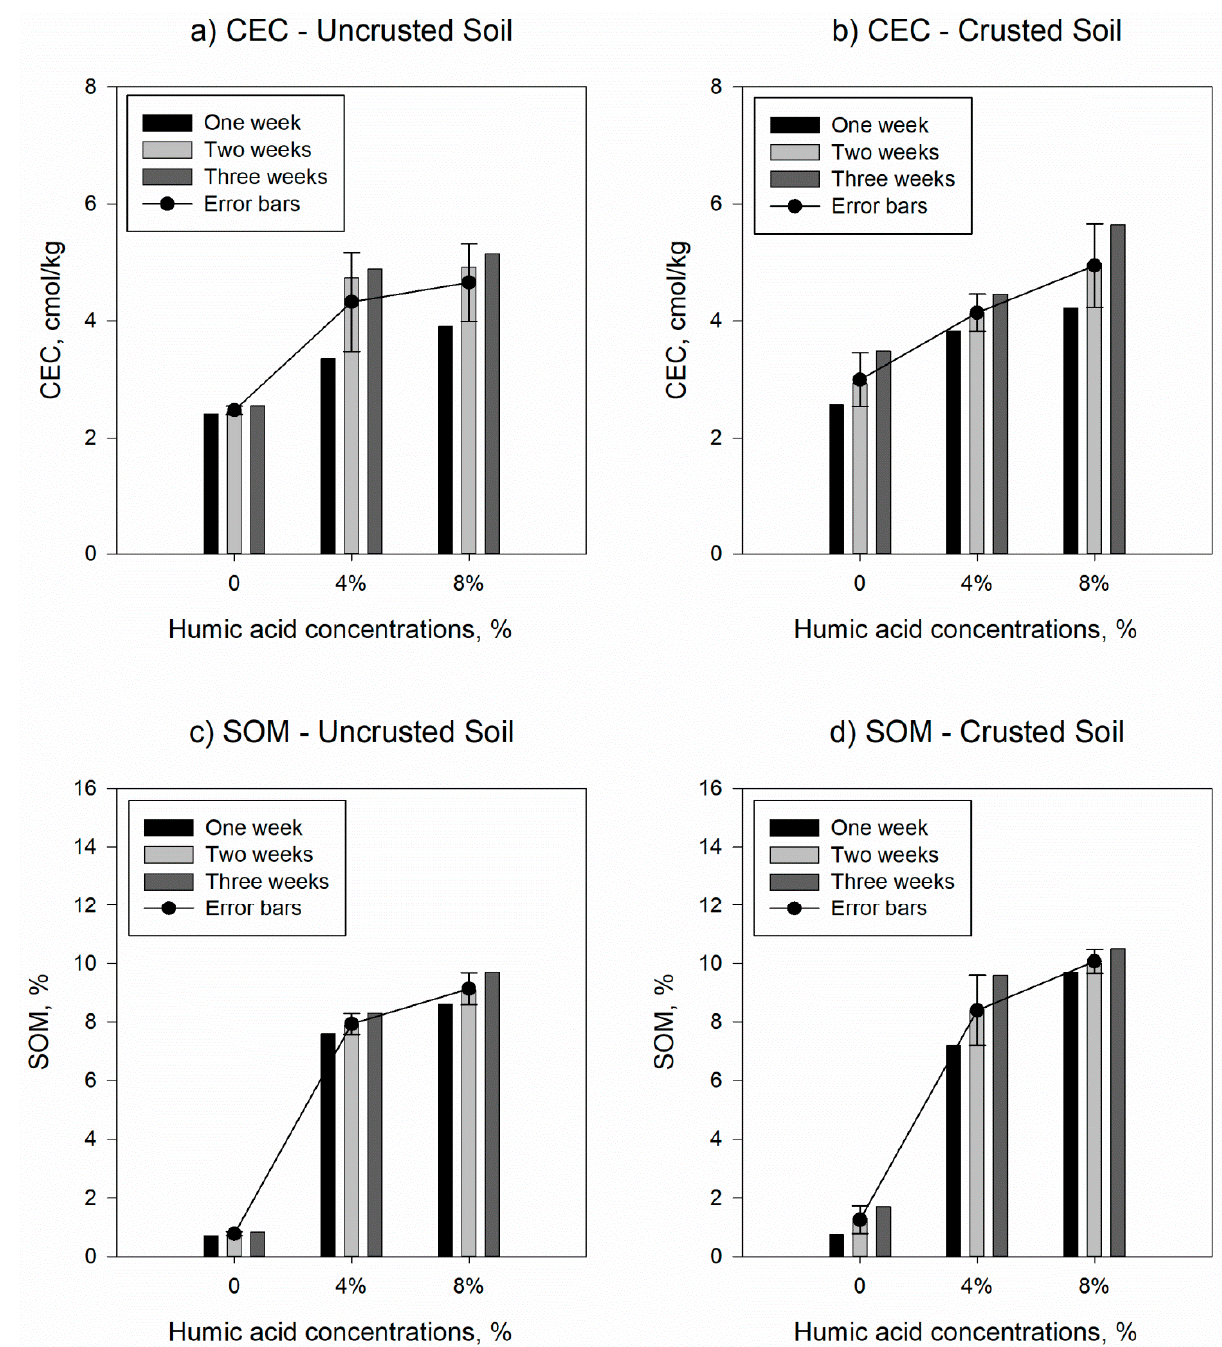
Figure 9. Influence of humic acid concentrations of 0%, 4%, and 8% on: ( a ) CEC of uncrusted soils, ( b ) CEC of crusted soils, ( c ) SOM of uncrusted soils, and ( d ) SOM of crusted soils at different curing times. The error bars are the standard deviations from the mean values of different curing times for each HA concentration.